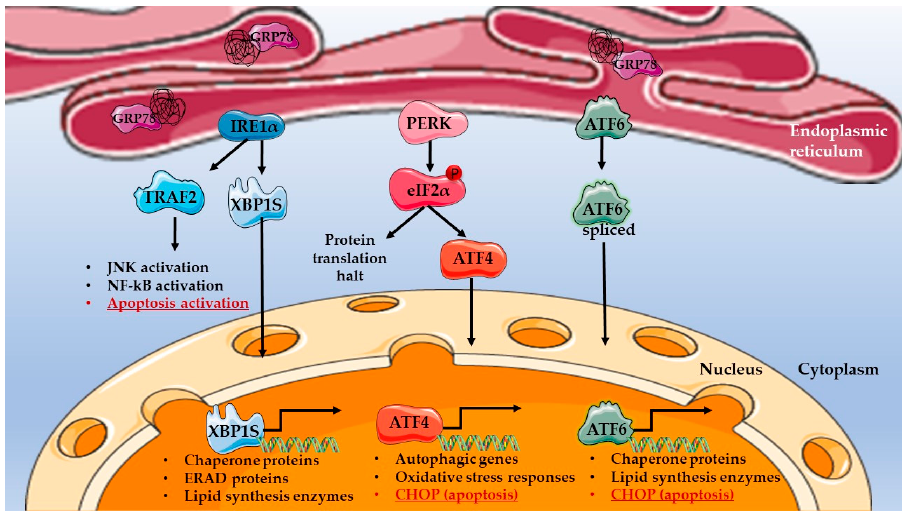
Figure 1. Unfolded protein response (UPR) pathway in ER stress conditions. The three different UPR axes are represented as follows: IRE1 α -mediated pathways are in blue, PERK-mediated pathways are in red and ATF6 in green. Pro-apoptotic UPR responses are underlined in red. The UPR sensor GRP78 is represented in violet, bound to misfolded proteins (in black) in the ER lumen. The illustration was designed using images from the Servier Medical art database (smart.servier.com, accessed on 26 December